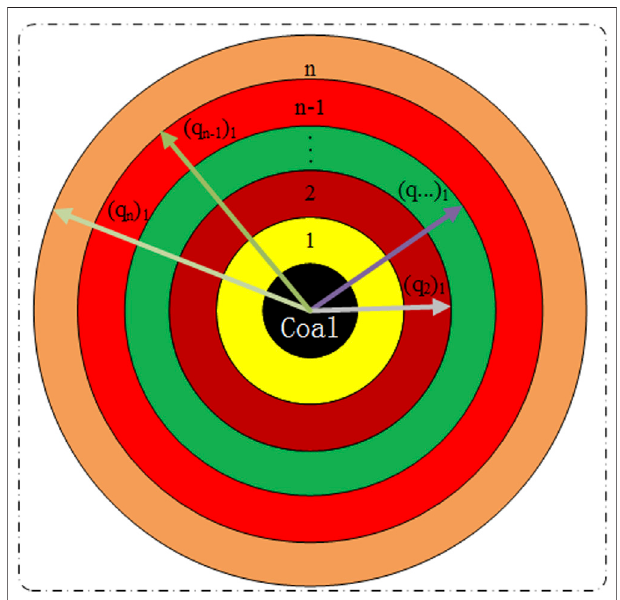
FIGURE 5 | Load condition of stratum no.1.